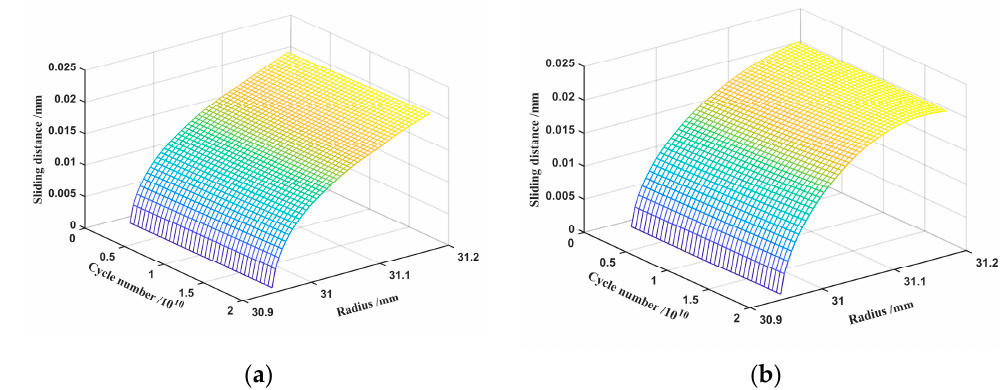
Figure 10. Sliding distance: ( a ) double-arc tooth profile; ( b ) involute tooth profile.